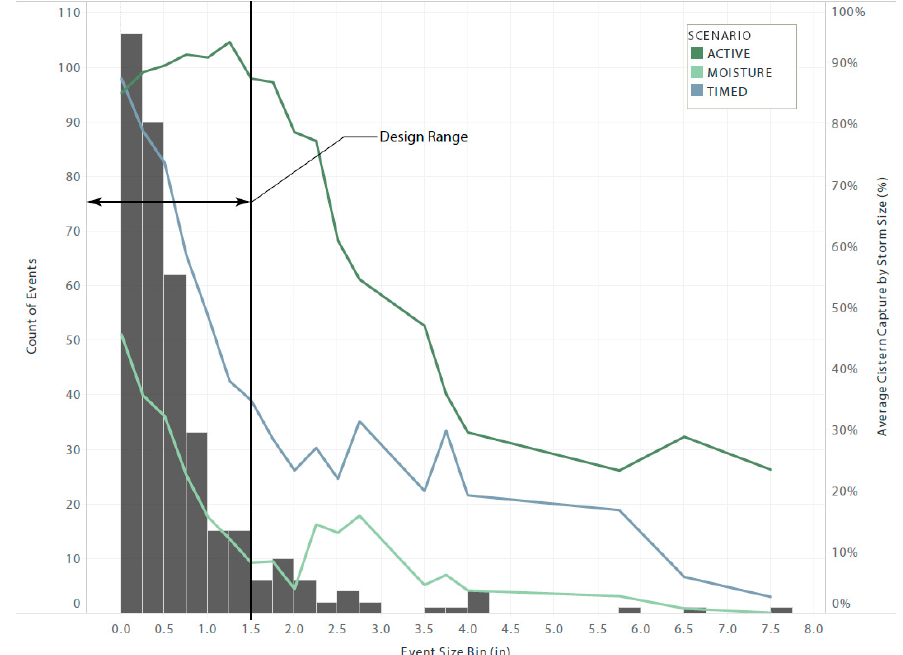
Figure 6. Scenario Capture Efficiency of Cistern from Events Larger than 0.1 inch (0.25 cm) (shaded area indicates number of rainfall events within a specific event size bin).